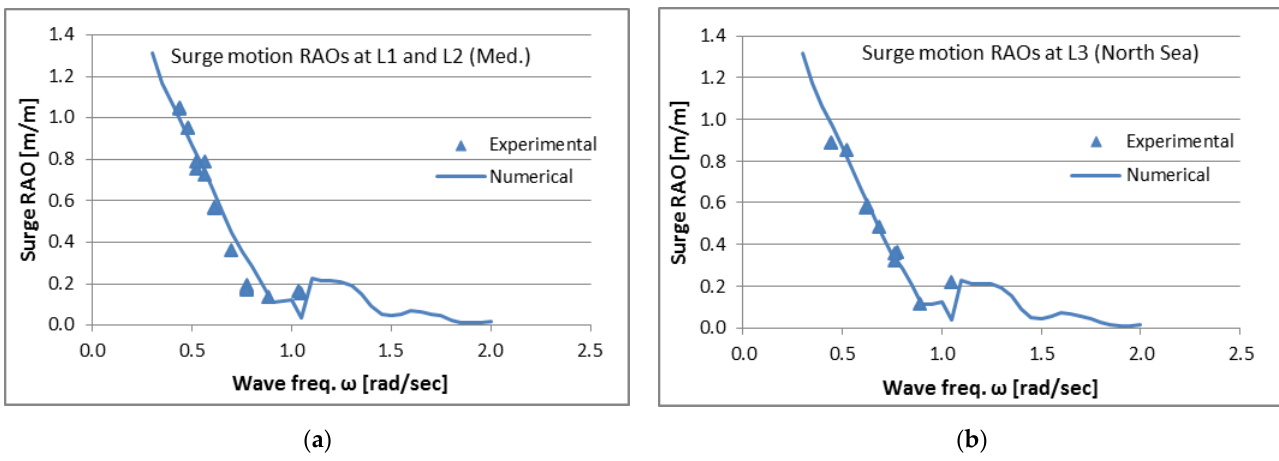
Figure 10. REFOS surge response amplitude operators’ (RAOs) comparisons for the: ( a ) Mediterranean and ( b ) North Sea installation locations.